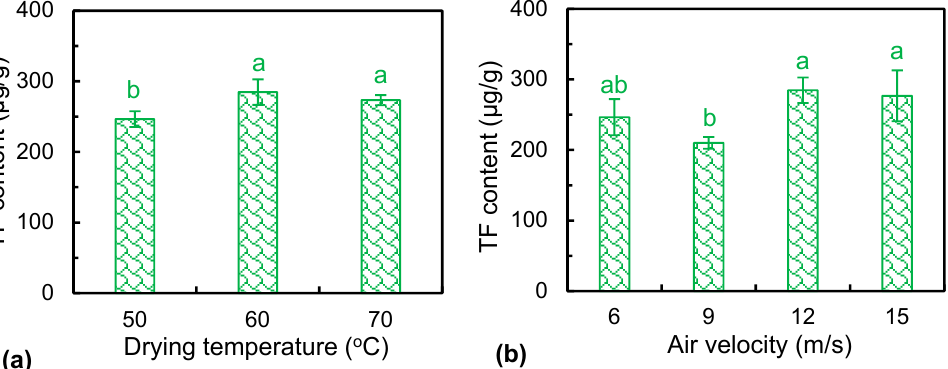
Figure 5. Total fl avonoid content of dried Ophiopogonis Radix under di ff erent drying temperatures Figure 5. Total flavonoid content of dried Ophiopogonis Radix under different drying temperatures ( a ) and air velocities ( b ). Di ff erent le tt ers (a–b) indicate the signi fi cant di ff erences at p < 0.05. ( a ) and air velocities ( b ). Different letters (a–b) indicate the significant differences at p <